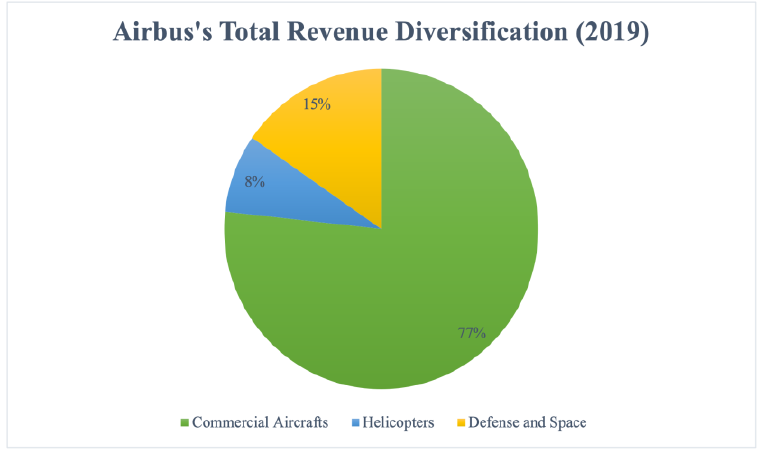
Figure 1. Airbus’s total revenue diversification. Source: Forbes